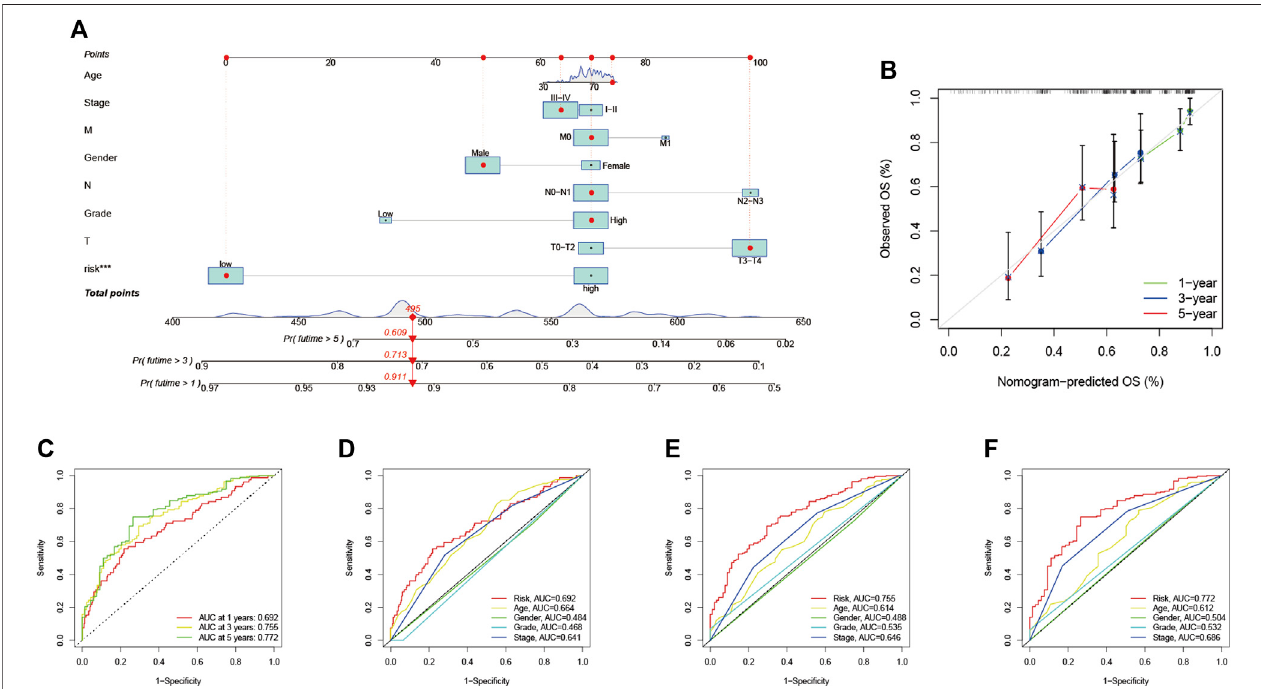
FIGURE 7 | Validation of prognostic ef fi ciency of risk signatures (A) Nomogram was used to predict survival in BLCA patients (B) 1-, 3-, and 5-years nomogram calibrationcurves (C) ROCanalysiswasusedtoestimatethepredictivevalueofprognosticfeatures.Theareaunderthe (D – F) curve(AUC)oftheriskscoreforpredicting overall survival at 1, 3, and 5 years and other clinical